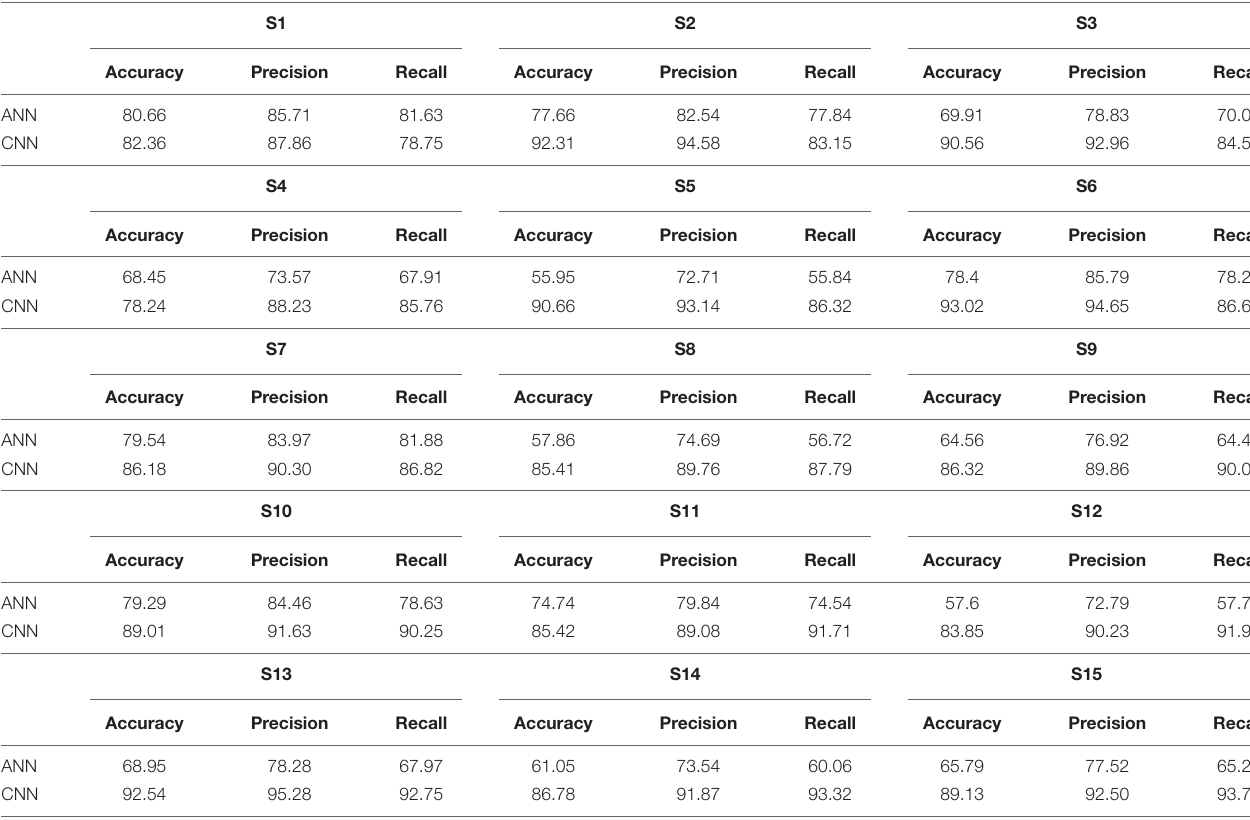
TABLE 1 | Artificial neural network (ANN) and convolutional neural network (CNN) accuracies, precision, and recall of all subjects (in percentage).